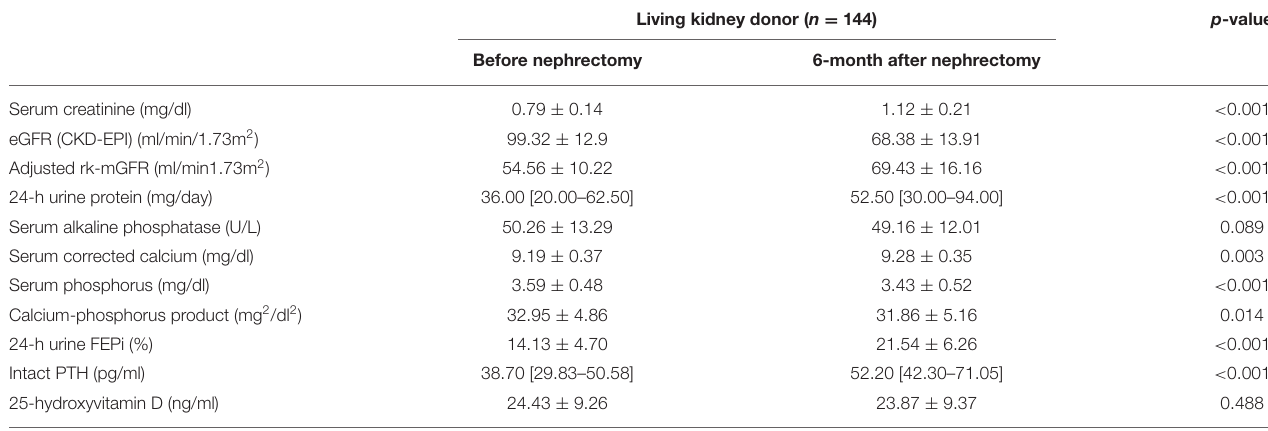
TABLE 2 | Biochemical parameters before and 6 months after uni-nephrectomy in the living kidney donors. Living kidney donor ( n = 144) p -value Before nephrectomy 6-month after nephrectomy Serum creatinine (mg/dl) 0.79 ±